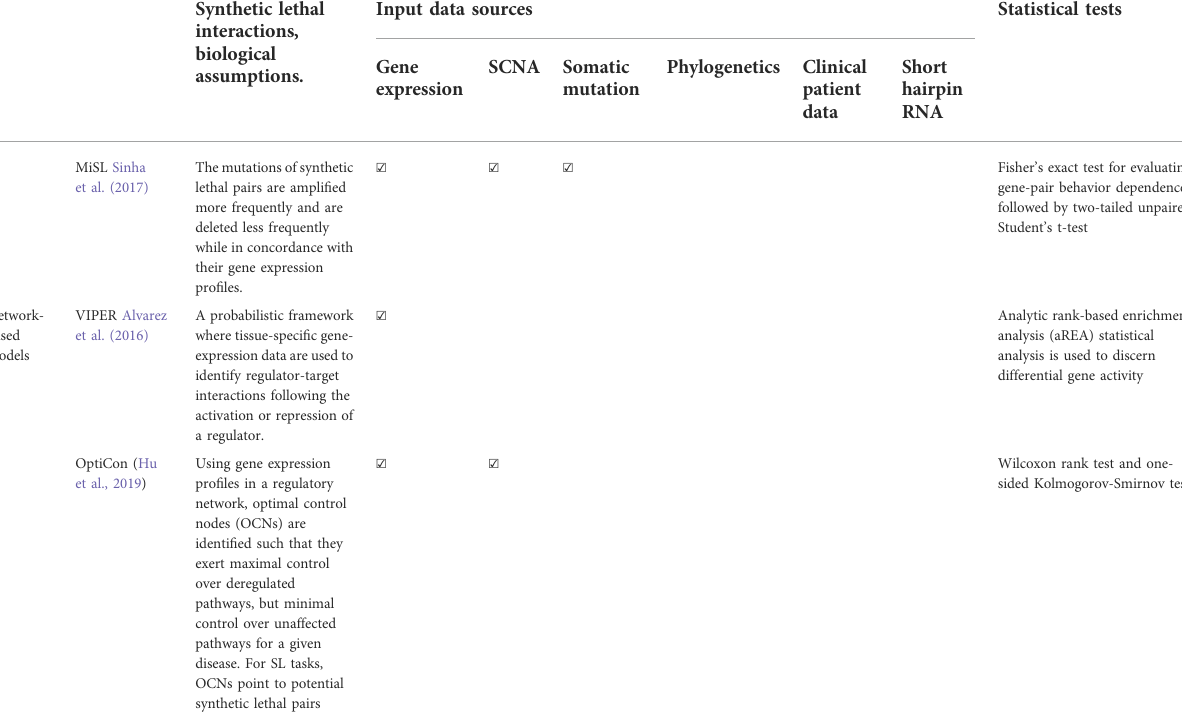
TABLE 2 ( Continued ) Biological assumptions, sources of input data, and network statistics for predictive